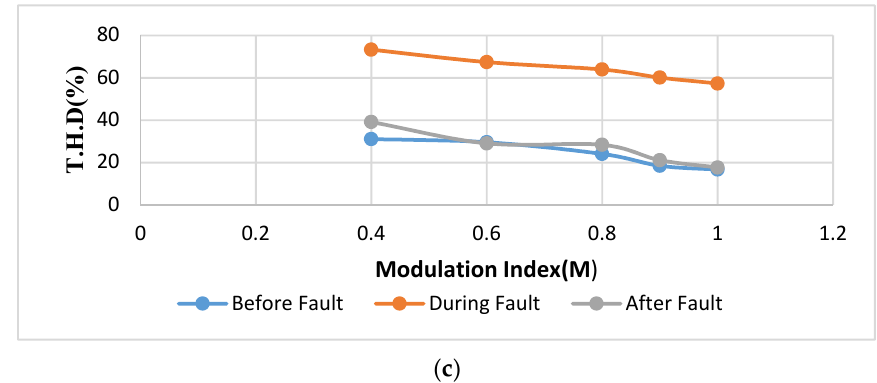
Figure 7. ( a ) Modulation index vs. efficiency, ( b ) modulation index vs. power loss, and ( c ) modulation index vs. THD.